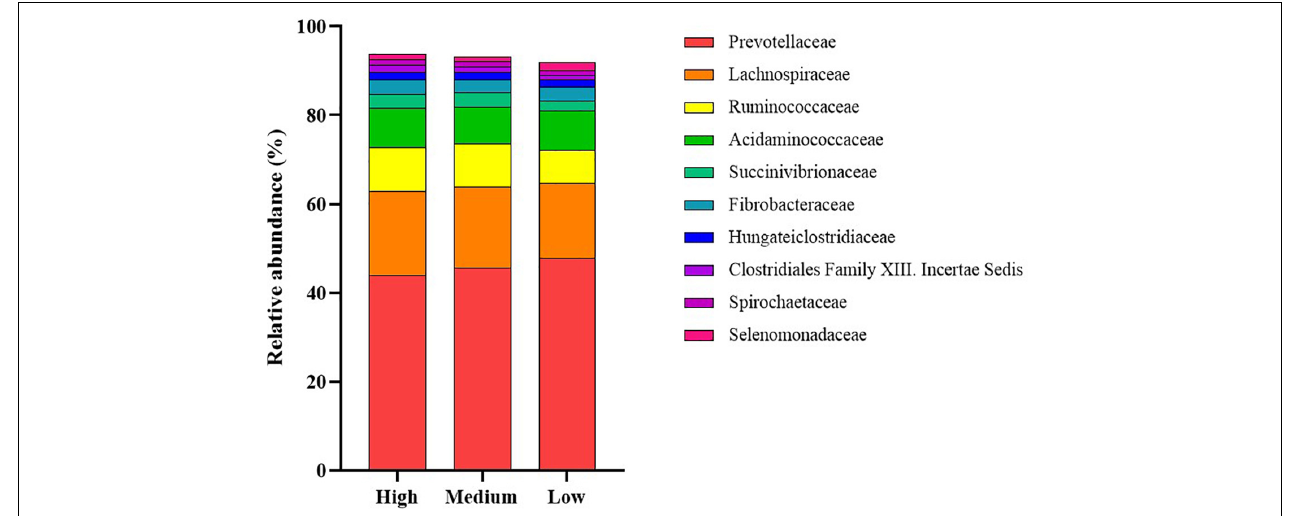
FIGURE 2 | Stack plot comparing differences, in the relative abundances of the ten most abundant rumen bacterial families, between cattle ranked as high, medium, and low for residual methane emissions.